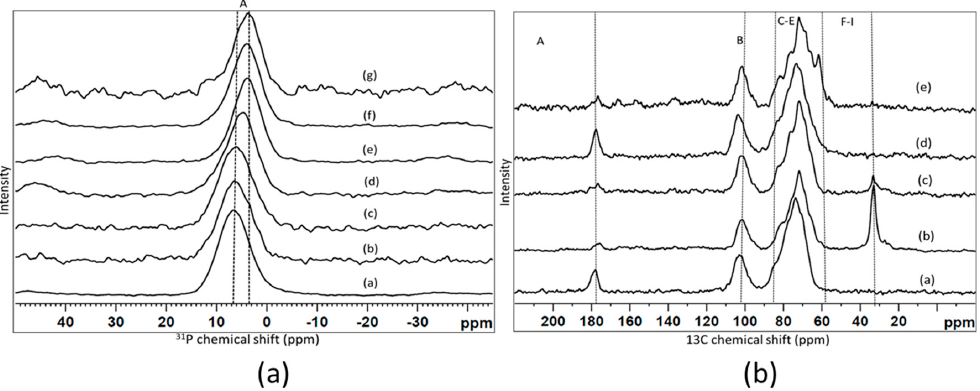
Figure 6. The plot ( a ) shows the 31P MAS-NMR spectrum of ( a ) bioactive glass, ( b ) type 2 scaffolds before cross-linking, ( c ) type 2 scaffolds after cross-linking with SrCl 2 ( d ) bioactive glass after 15 h in Tris/HCl, ( e ) type 3 scaffolds cross-linked with SrCl 2 after 15 hrs in a Tris/HCl buffer, ( f ) type 2 scaffolds cross-linked with CaCl 2 after 15 hrs in Tris/HCl, and ( g ) type 2 scaffolds cross-linked with CaCl 2 after two weeks in Tris/HCl. The plot ( b ) shows 13C cross-polarization (CP)-MAS-NMR spectra for ( a ) sodium alginate, ( b ) type 1 scaffolds after crosslinking with SrCl2, ( c ) type 3 scaffolds cross- linked with CaCl 2 , ( d ) type 3 scaffolds cross-linked with SrCl 2 after 15 hrs in a Tris/HCl buffer, ( e ) type 3 scaffolds cross-linked with SrCl 2 after two weeks in a Tris/HCl buffer. The capital letters refer to the resonance assignments listed out in Tables 5 and